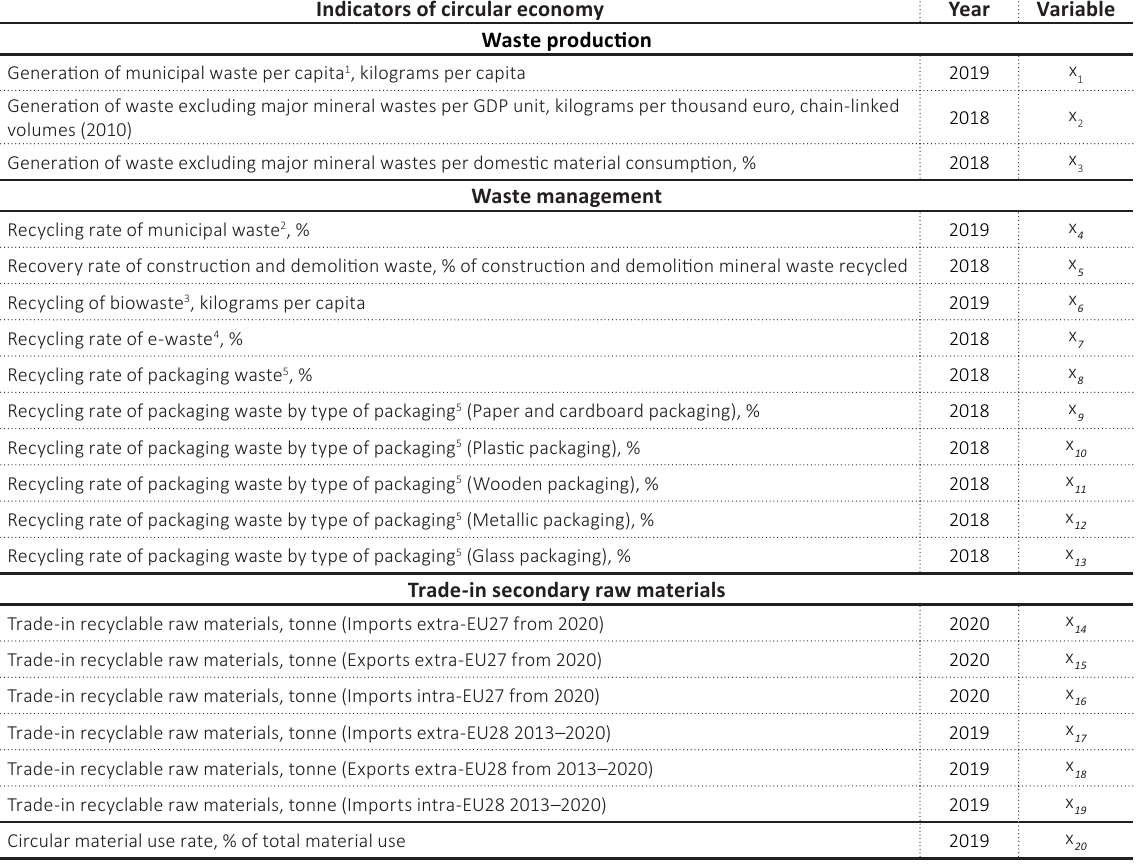
Table 1. List of the key indicators of circular economy in the EU member countries